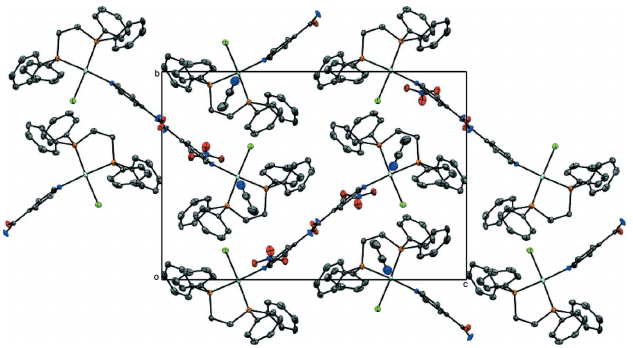
Figure 2 Perspective view of the packing structure of the title salt along the crystallographic a -axis; H atoms are omitted for clarity.